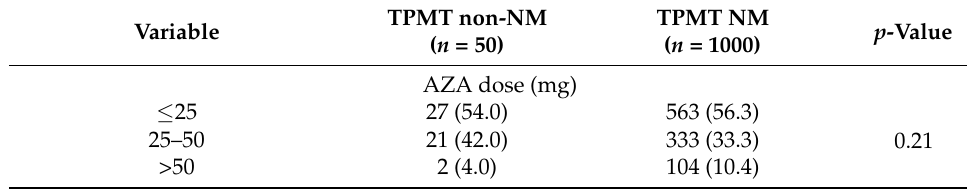
Table 2. Outcome post-AZA